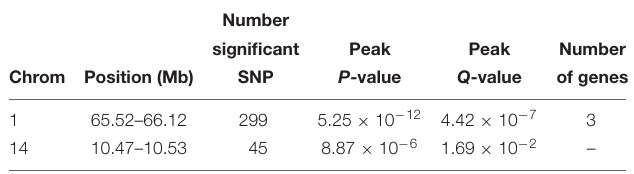
TABLE 5 | Putative selection signatures identified across Cochinchina and Brahma Brazilian breeds in the hapFLK analysis.